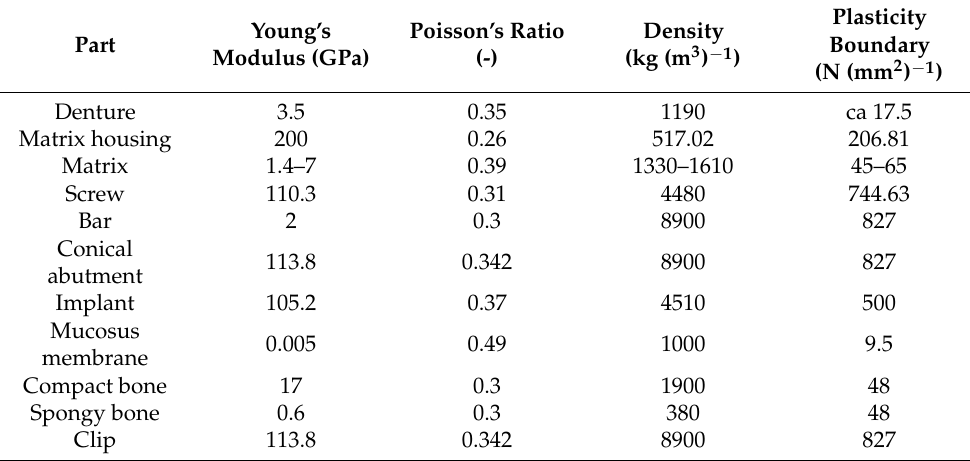
Table 2. Material properties.